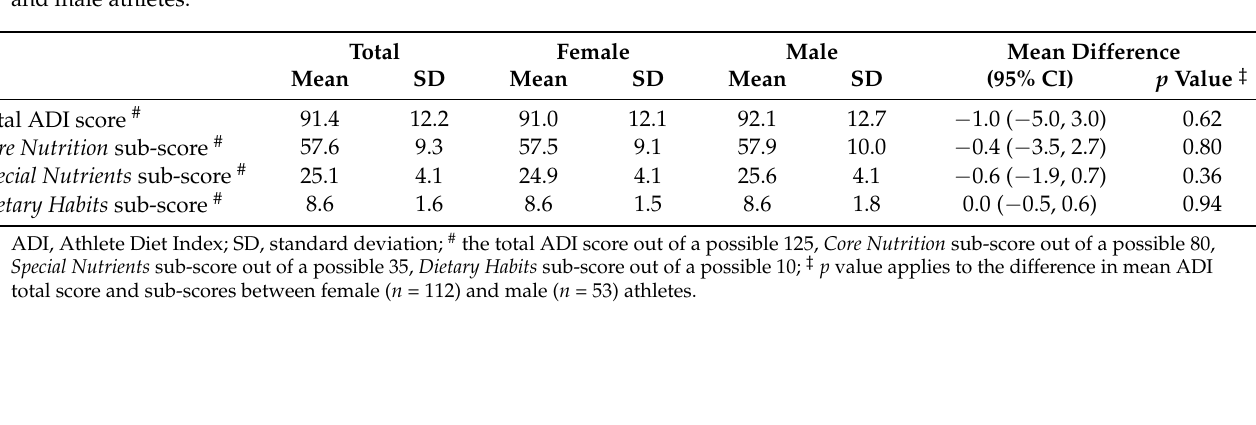
Table 3. Mean total ADI scores and sub-scores for all athletes ( n = 165), and the difference in mean scores between female and male